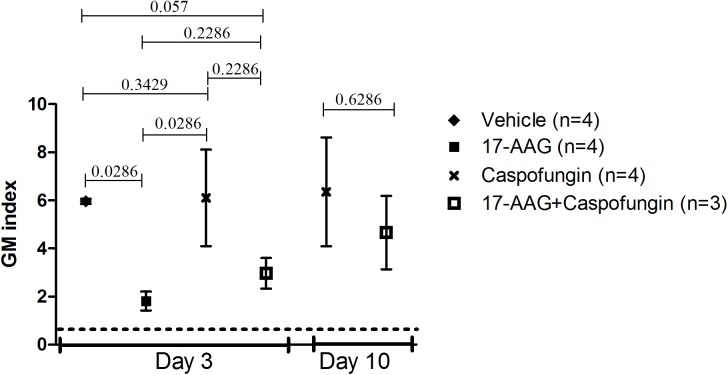
GM-index in blood of neutropenic rats with invasive pulmonary aspergillosis during treatment with 17-AAG and/or Caspofungin.Black diamond (♦): vehicle treatment, black square (■): monotherapy 17-AAG, cross (x): monotherapy Caspofungin, open square (□): combination therapy of 17-AAG and Caspofungin. Data were generated by determining the Galactomannan (GM)-index with the Platelia assay for three to four rats per group. Errors bars represent SEM. According to the manufacturer’s manual, GM-index of >0.5 is considered positive for A. fumigatus.